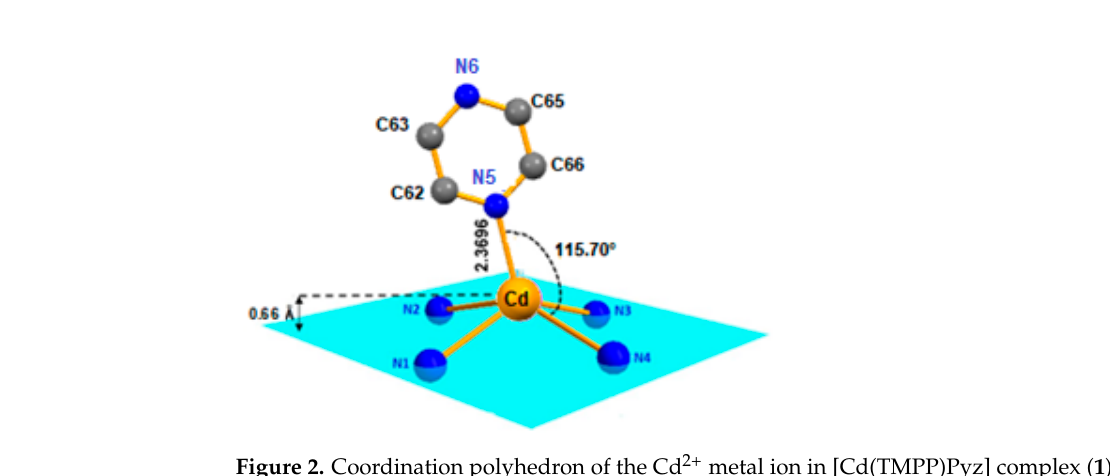
Figure 2. Coordination polyhedron of the Cd 2+ metal ion in [Cd(TMPP)Pyz] complex ( 1 ). Table 1. [Cd(TMPP)(Pyz)] ( 1 ) with stereochemical parameters (Å) and related coordination of some cadmium porphyrin complexes.